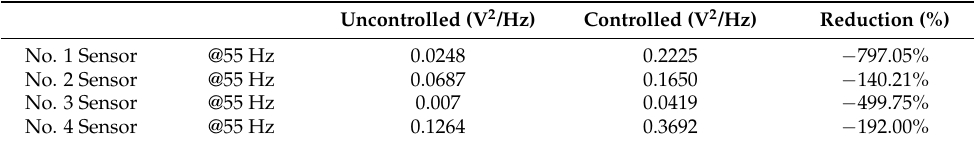
Table 10. Peak values of PSD curves of sensor